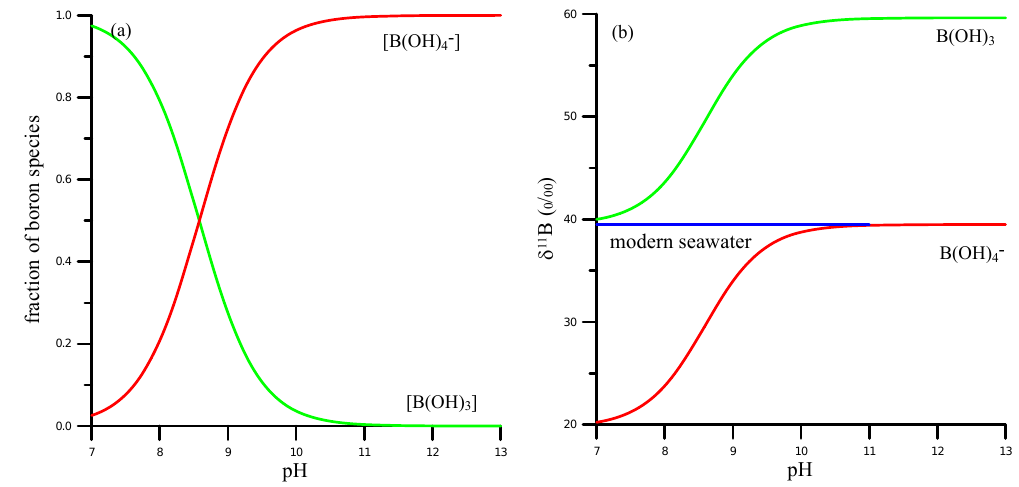
Fig. 1. Fraction (a) of the major dissolved boron species B(OH) 3 (green curve) and B(OH) 4– (red curve) in seawater, using pK b =8.597 (Dickson, 1990) and stable boron isotope fractionation (b) between them as a function of pH, using α 4 − 3 =0.974 (Klochko et al., 2006). At low pH (pH<7), virtually all of the boron in seawater is in the B(OH) 3 species; conversely, at high pH (pH > 10), virtually all of the boron is in the B(OH) 4- species (Fig. 1a). Only the B(OH) 4 − incorporated into the marine bio-carbonates is one of the essential hypotheses for using boron isotopic composition in marine bio-carbonate to reconstruct the paleo-environment (Hemming and Hanson, 1992). The isotope